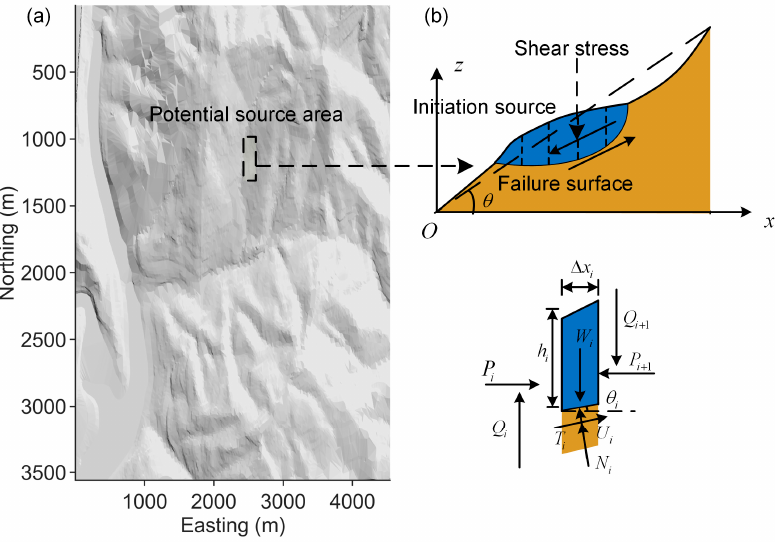
Figure 1. The schematic diagram of the slope source initiation model. ( a ) Potential source area in the debris-flow gully. ( b ) The average slope along the gully direction.